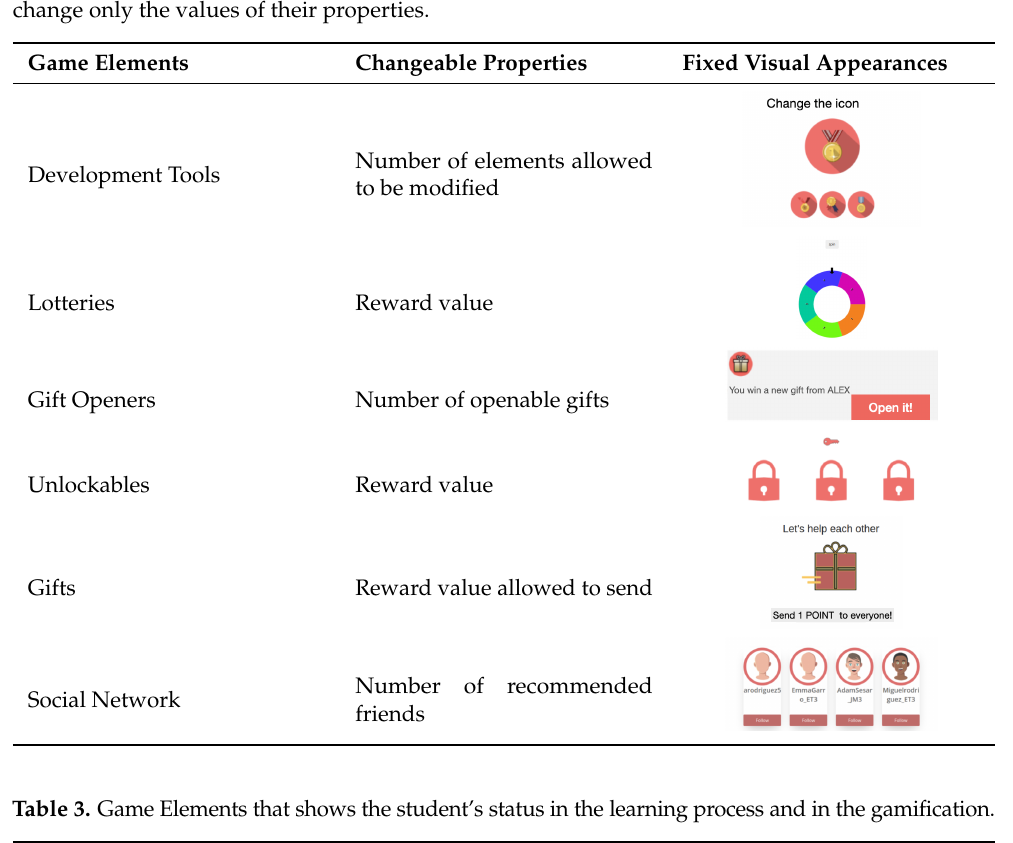
Table 2. Details of the Game Element Properties changeable as a function of the global score values. These game elements have the same appearance during the whole itinerary and the global score will change only the values of their properties.